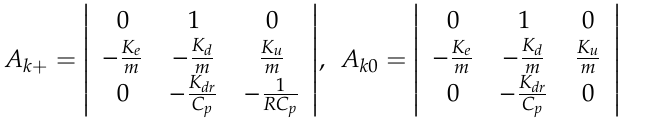
K e —elasticity coe ffi cient, K d —damping coe ffi cient, K u —reverse piezoelectric e ff ect, K dr —direct piezoelectric e ff ect, m —weight, A k + —plus or minus control (with external power source), A k 0 —null piezoelectric effect, m —weight, A k+ —plus or minus control (with external power source), A k 0 —null control (without external power source, only reactive control (without external power source, only reactive elements).